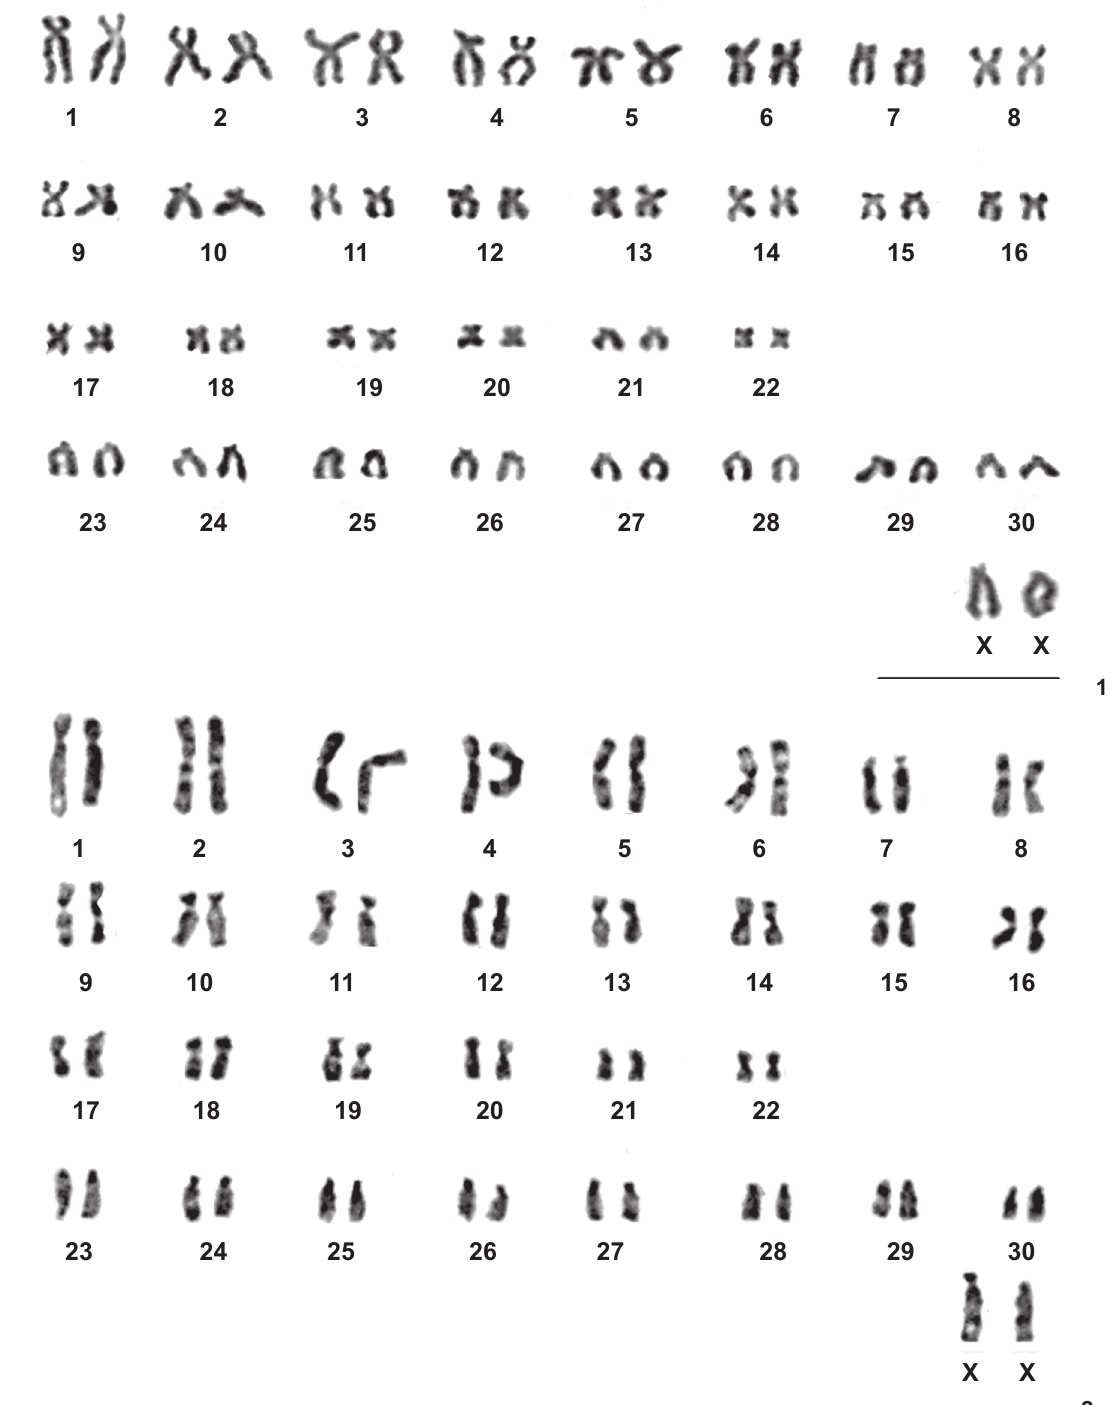
Figures 1-2. Karyotype of a female W. pyrrhorhinus from Fazenda Salinas, Morro do Chapéu, Bahia (2n = 62, FNa = 104): (1) Giemsa staining; (2) G-bands. Scale bars = 10